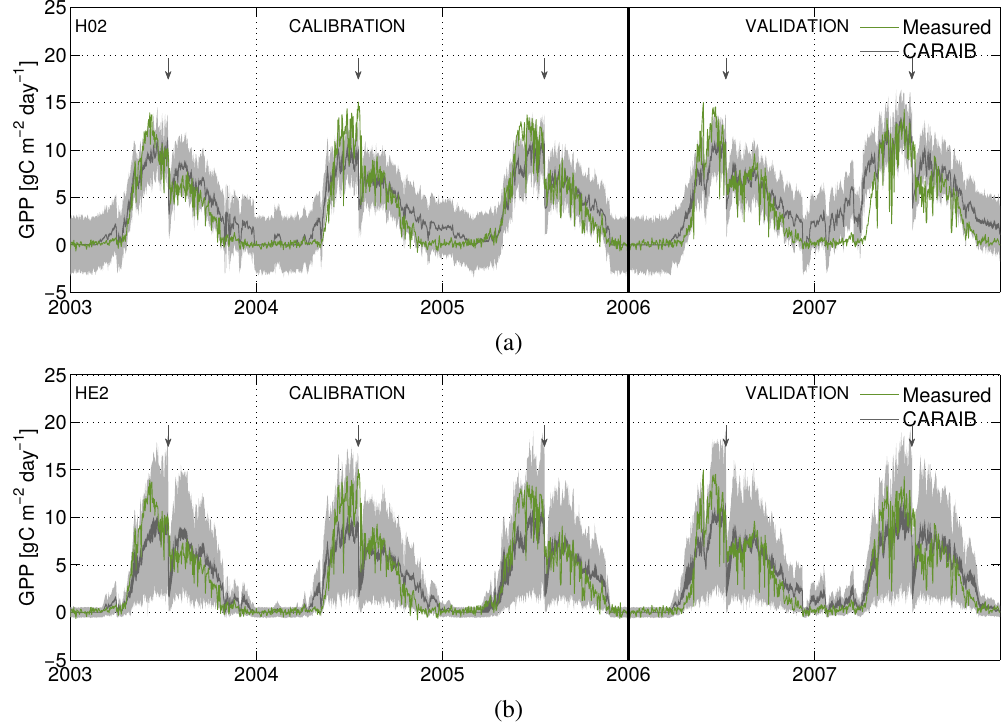
Figure 6. Measured and modelled GPP (gCm − 2 day − 1 ) at the Monte Bondone site in calibration (2003–2005) and validation (2006–2007) for the inferred homoscedastic HO2 (a) and heteroscedastic HE2 (b) inversions. The 95% confidence interval of total predictive uncertainty is depicted using the light grey shaded